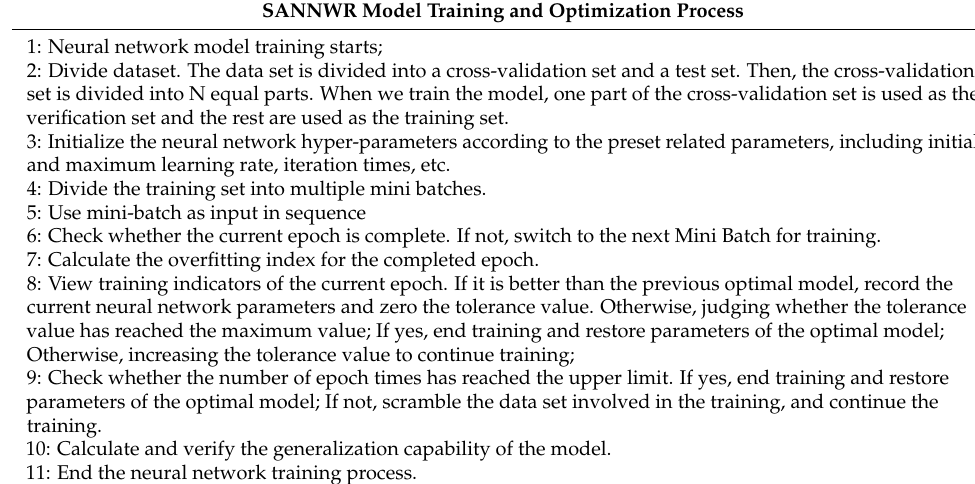
Table 3. The training process of SANNWR.